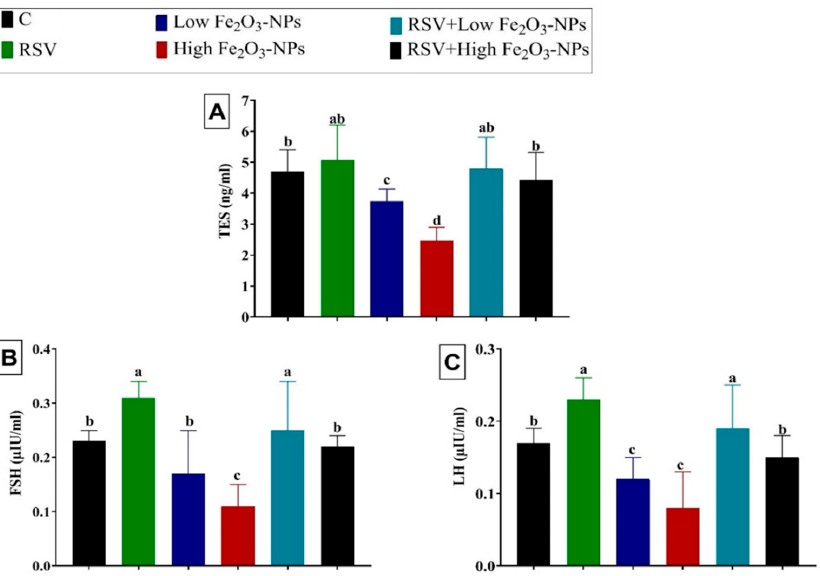
Figure 3. The effect of resveratrol (RSV; 20 mg/kg b.wt) and/or iron oxide nanoparticles (Fe 2 O 3 -NPs 3.5 or 7 mg/kg bwt) administration for eight weeks on the serum levels of male sexual hormones, including testosterone (TES) ( A ), follicle-stimulating hormone (FSH) ( B ), and luteinizing hormone (LH) ( C ) in male rats. Data expressed as mean ± SD, n = 9 for each group. Different letters (a, b, c, and d) on columns indicate statistically significant differences at p < 0.05 between the different